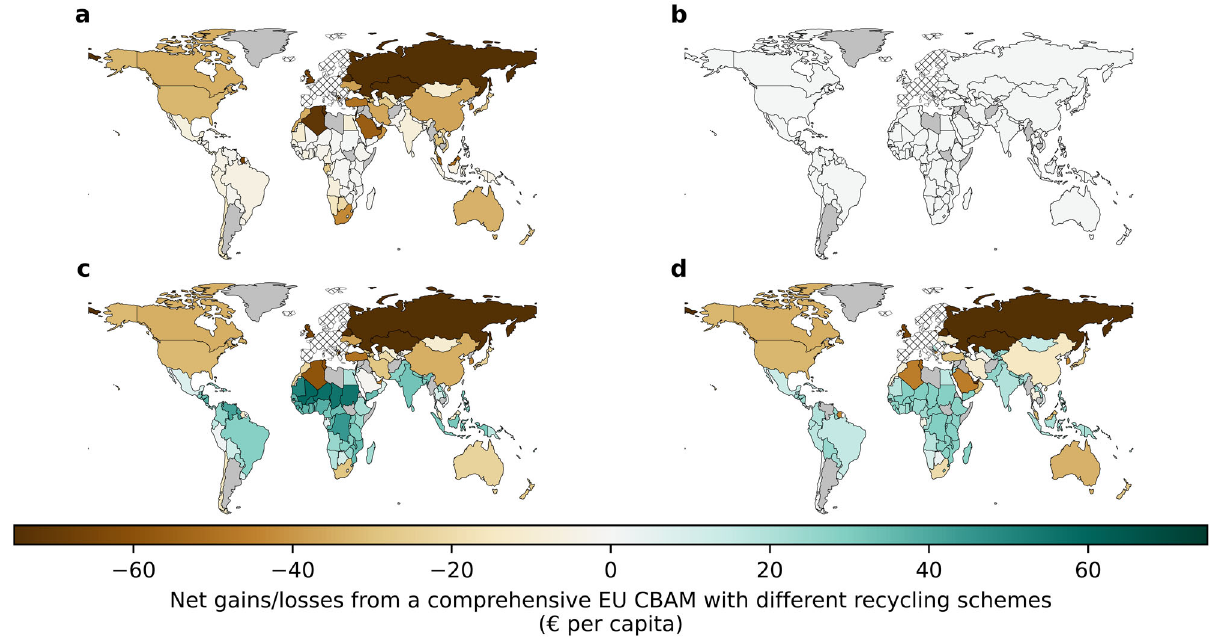
Fig. 4 Inclusiveness of a comprehensive EU CBAM without export rebates if the revenue is fully recycled towards non-EU countries based on different indicators. The proportion of the revenue each country receives is estimated based on the following indicators (see Materials and Data for details): a No recycling; b Emissions covered by the comprehensive EU CBAM; c Historical impacts of anthropogenic warming on economic output 20 ; d Difference in per capita Gross Domestic Product to the EU average. Losses are assumed to correspond to the upstream pressure, measured as the value of CO 2 emissions caused in a country to supply the fi nal demand in the EU multiplied by a carbon price of 100 € per tCO 2 . Grey indicates lack of data, hatchings indicate member countries of the EU ETS. Supplementary Fig. 2 shows the revenue recycled to each individual country on a per capita